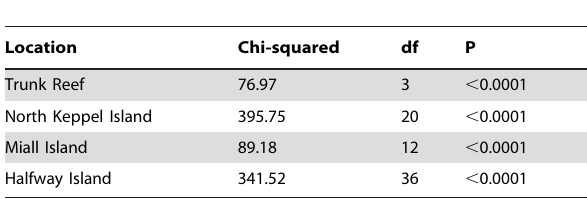
Table 7. Results of Pearson’s Chi-square test comparing temporal changes in Symbiodinium assemblages at each